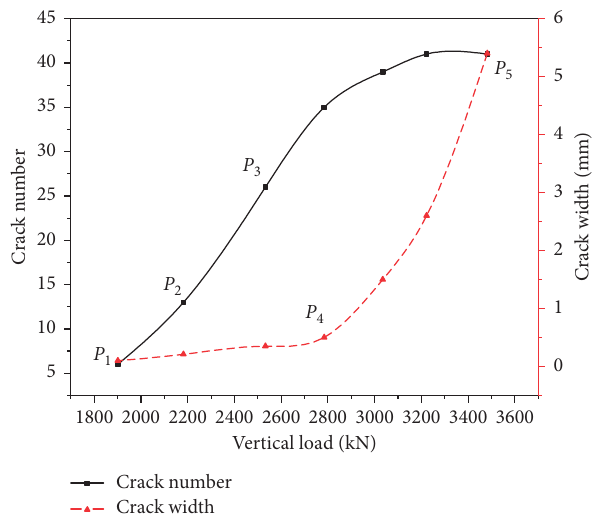
Figure 15: Variation of the number and width of cracks.